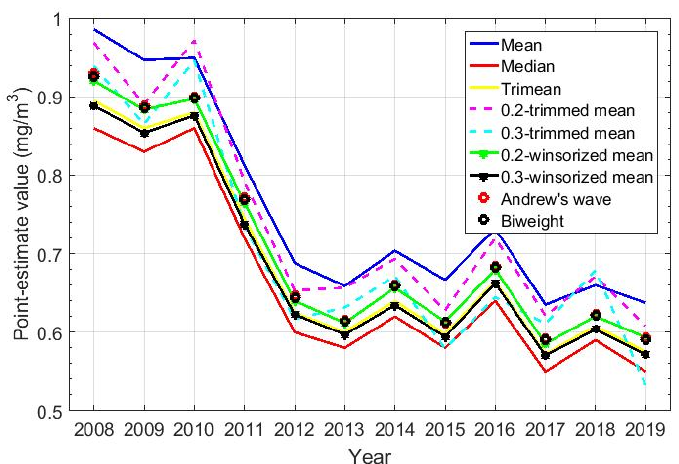
Figure 5. Graphical representation of the location estimates for the twelve years under study. Location estimators: mean, median, trimean, 0.2-trimmed mean, 0.3-trimmed mean, 0.2-winsorized mean, 0.3-winsorized mean, Andrew’s wave, and biweight.